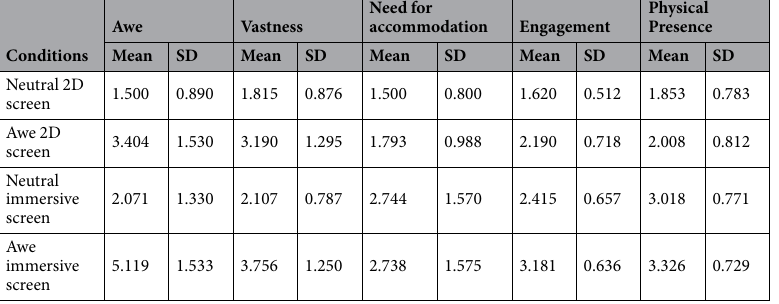
Table 1. Descriptive Statistics of Awe, Vastness, Need for Accommodation, Engagement, and Physical Presence. Note . n =